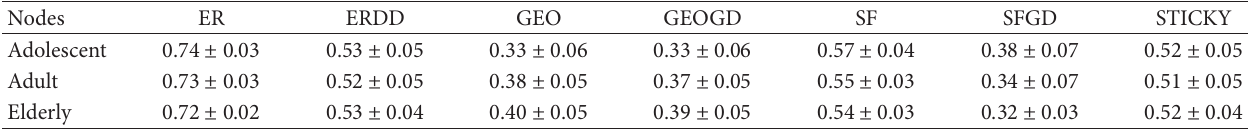
Table 5: Average clustering coefficient difference ratio in different